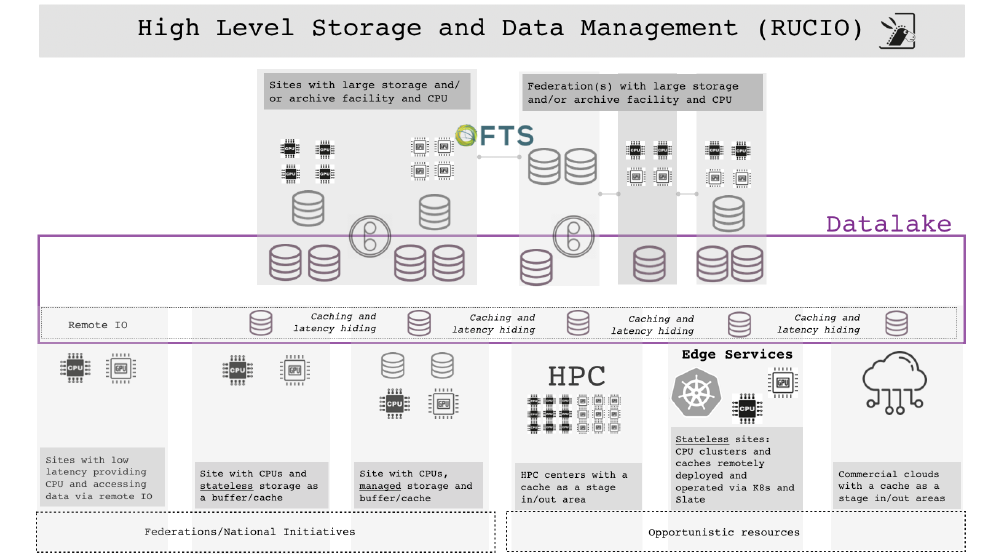
Figure 3. (center) Data Lake sketch composed by sites and federations holding the bulk of the data regions, and the di ff erent types of computing-oriented sites, commercial clouds and HPCs accessing the Data